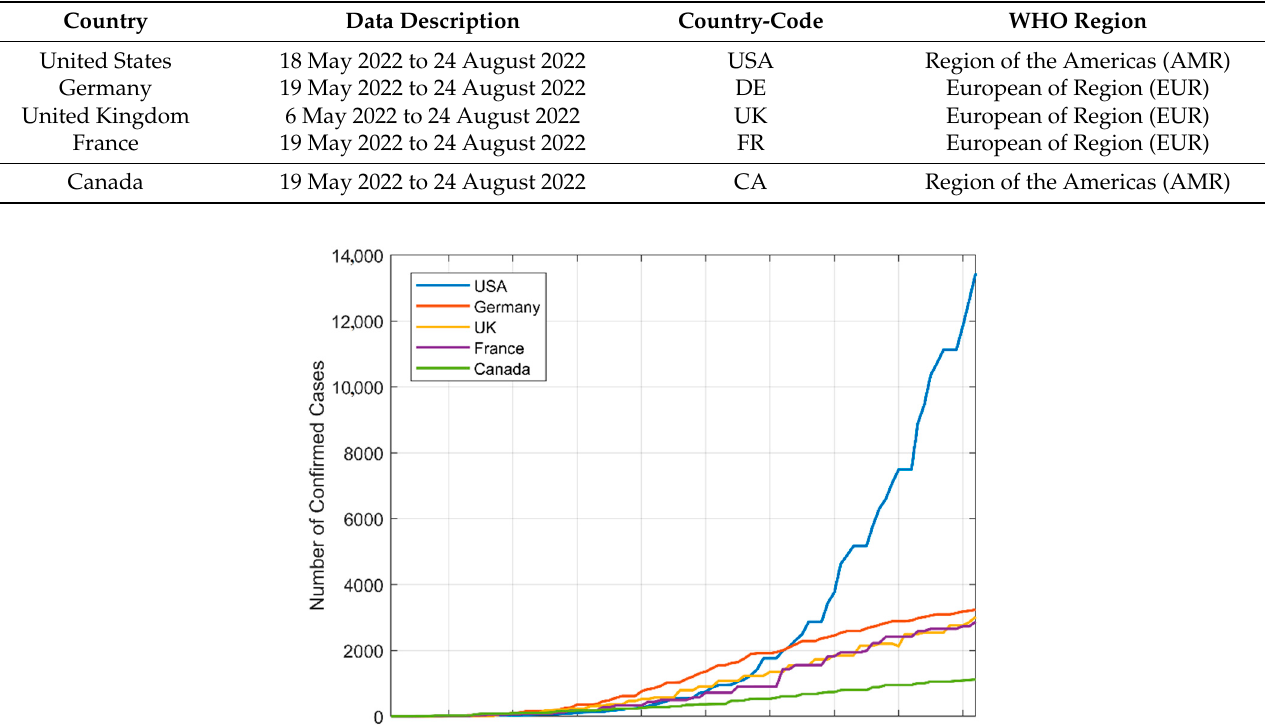
Table 2. Data description.